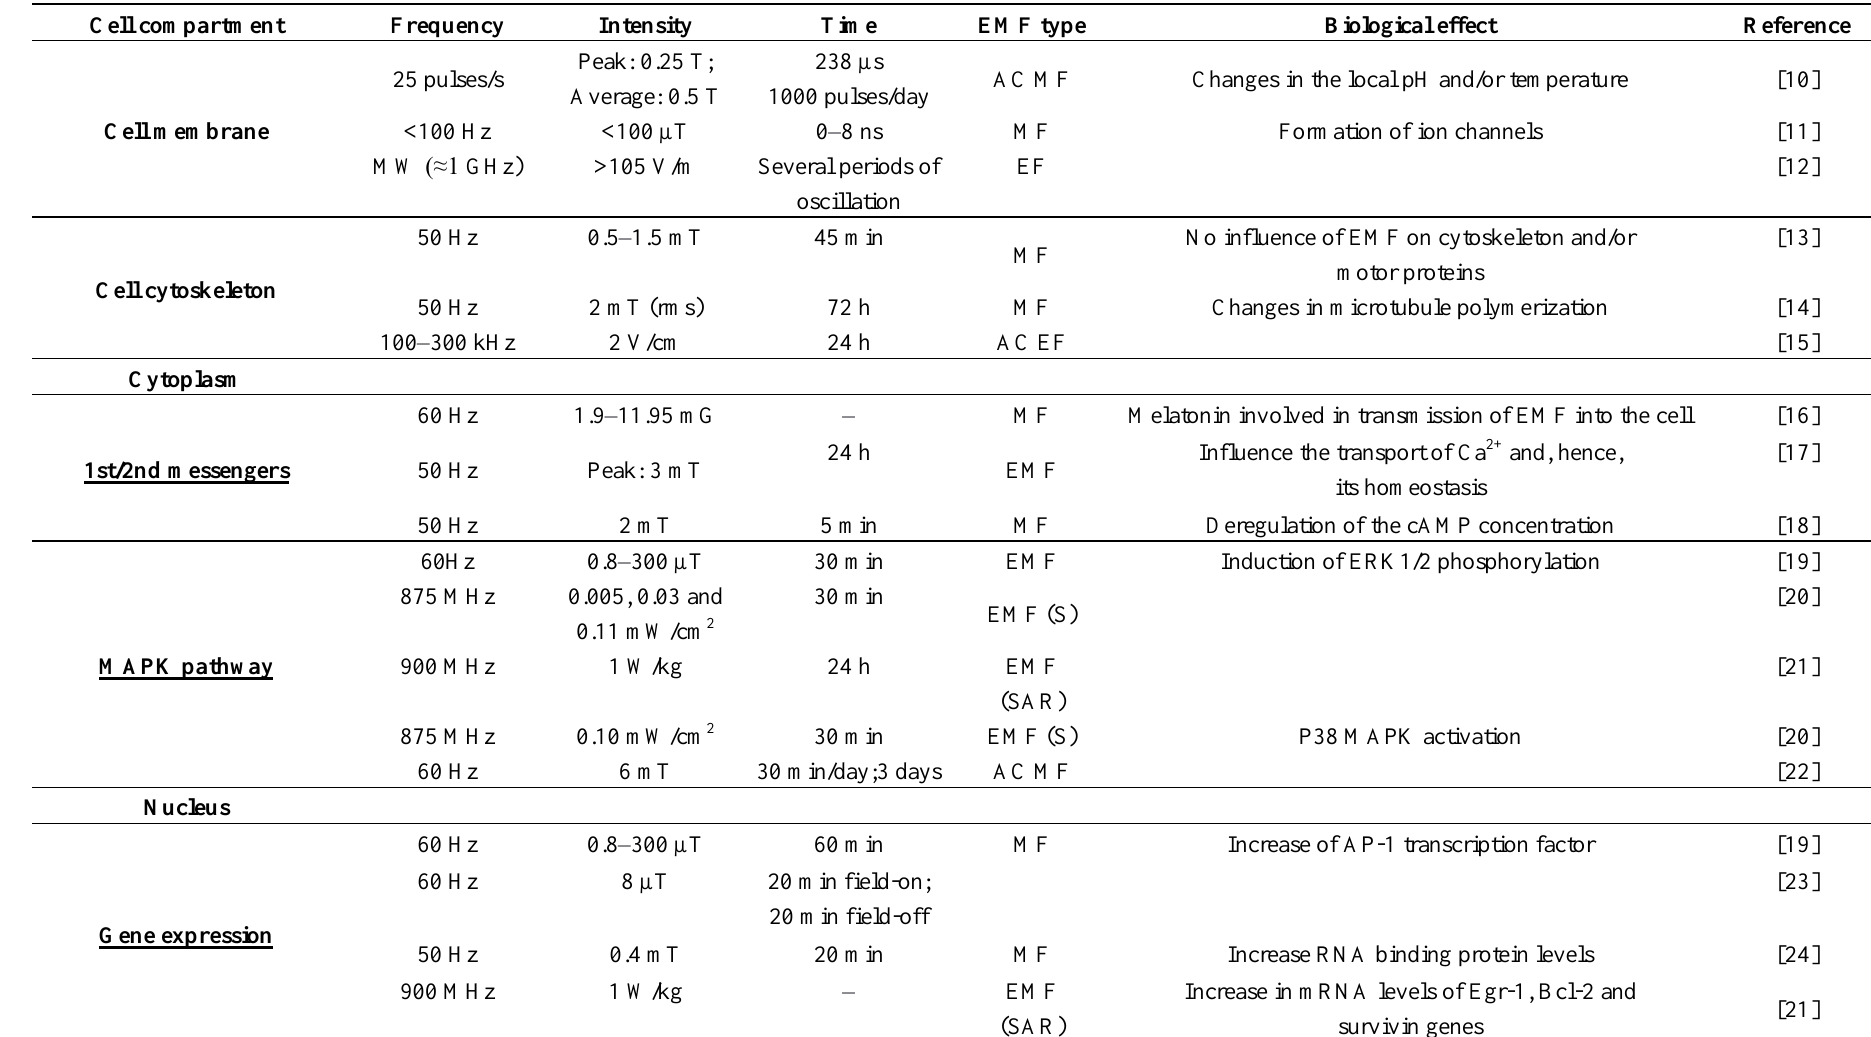
Table 1. Main characteristics of field applied and findings from in vitro